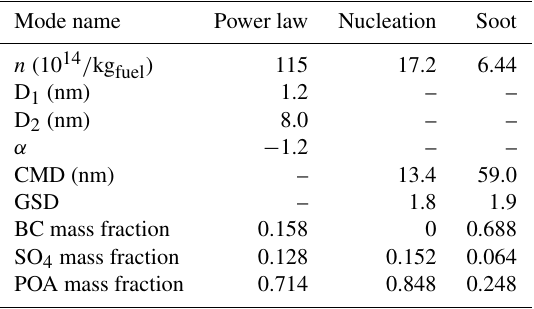
Table 1. Mode parameters of the trimodal fit on the measured EF- PSD and the estimated particle